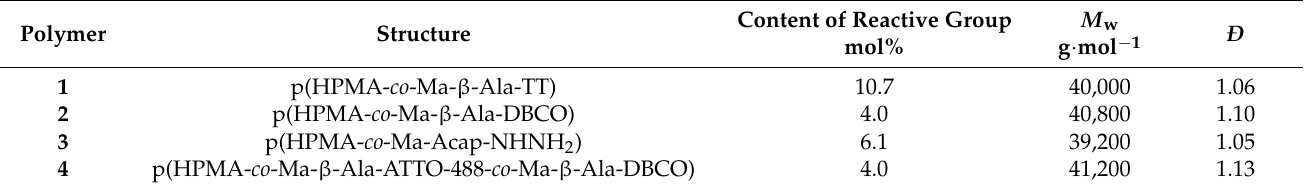
Table 1. Characterization of polymer precursors.